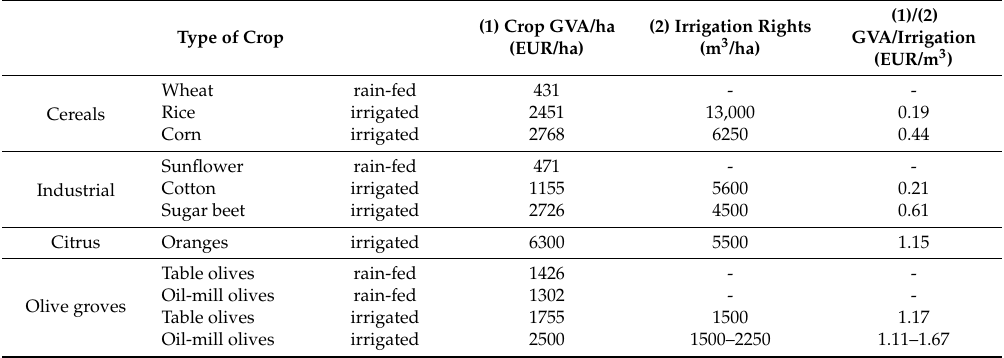
Table 5. Productivity of rain-fed and irrigated crops in the Guadalquivir RB, 2012.